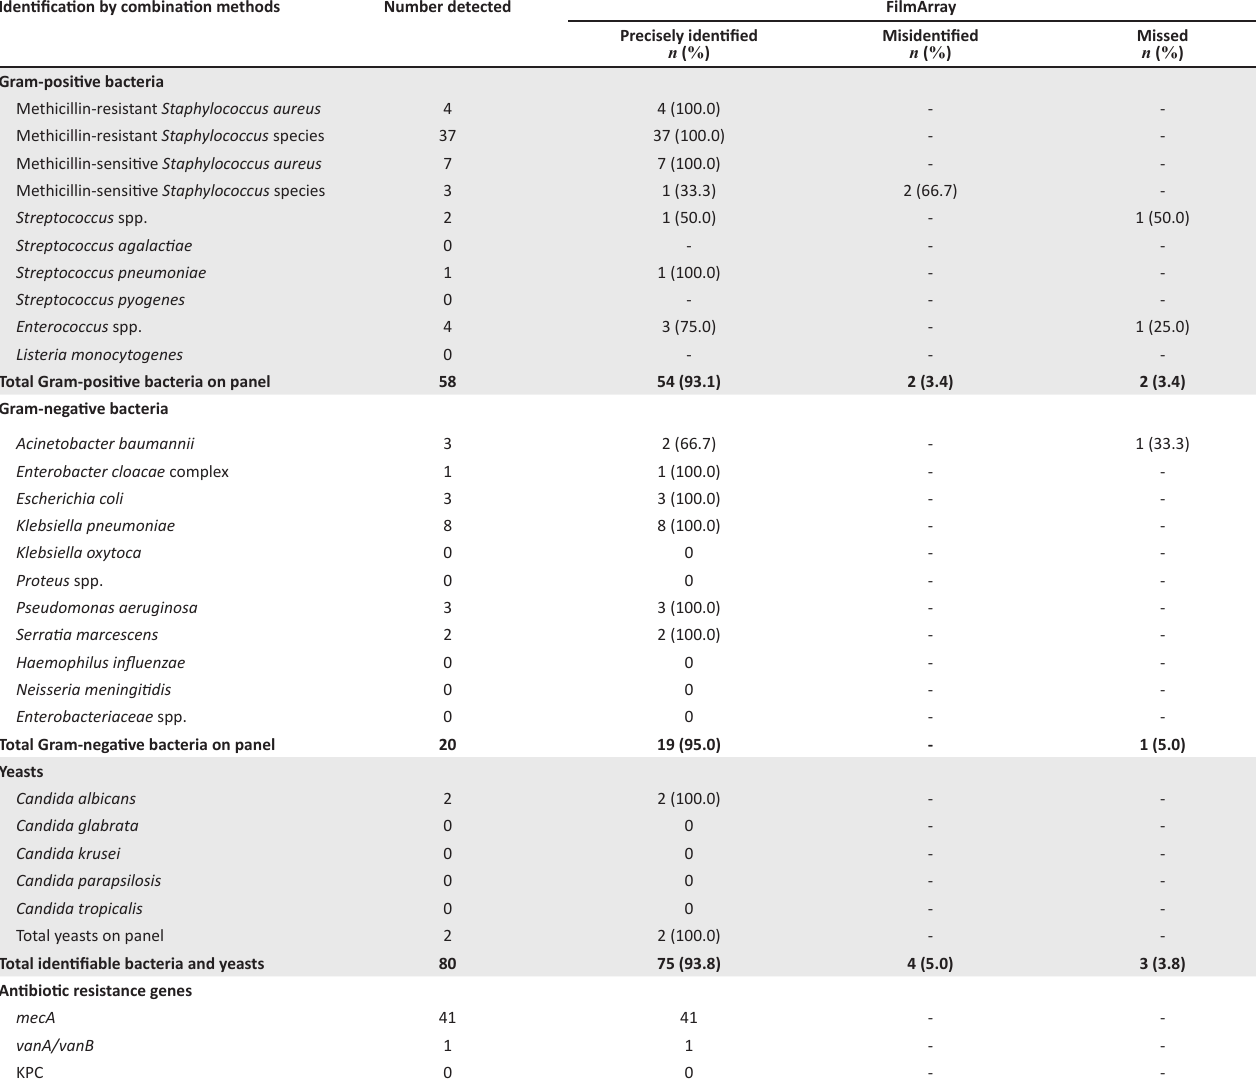
TABLE 2: Performance of FilmArray on blood cultures with one type of organism – by microorganism and antibiotic resistance marker Identification by combination